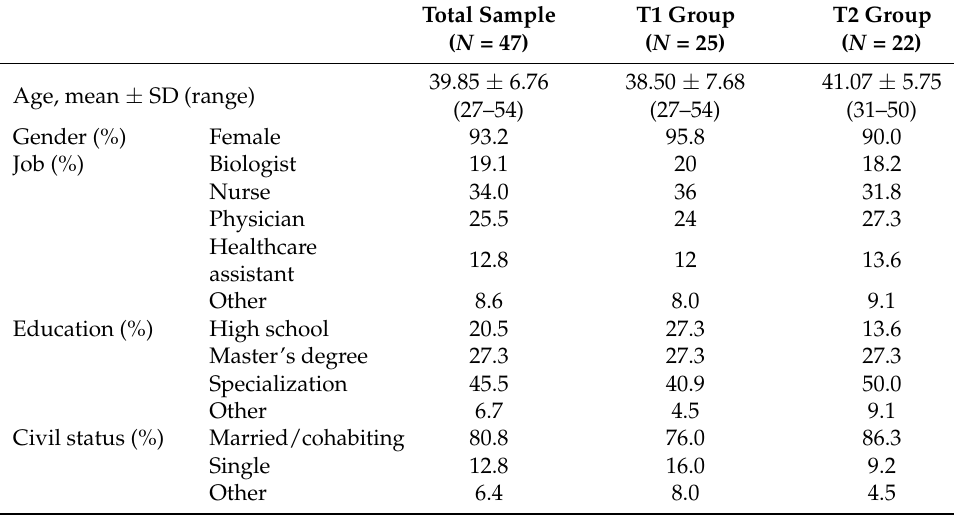
Table 1. Main characteristics of the